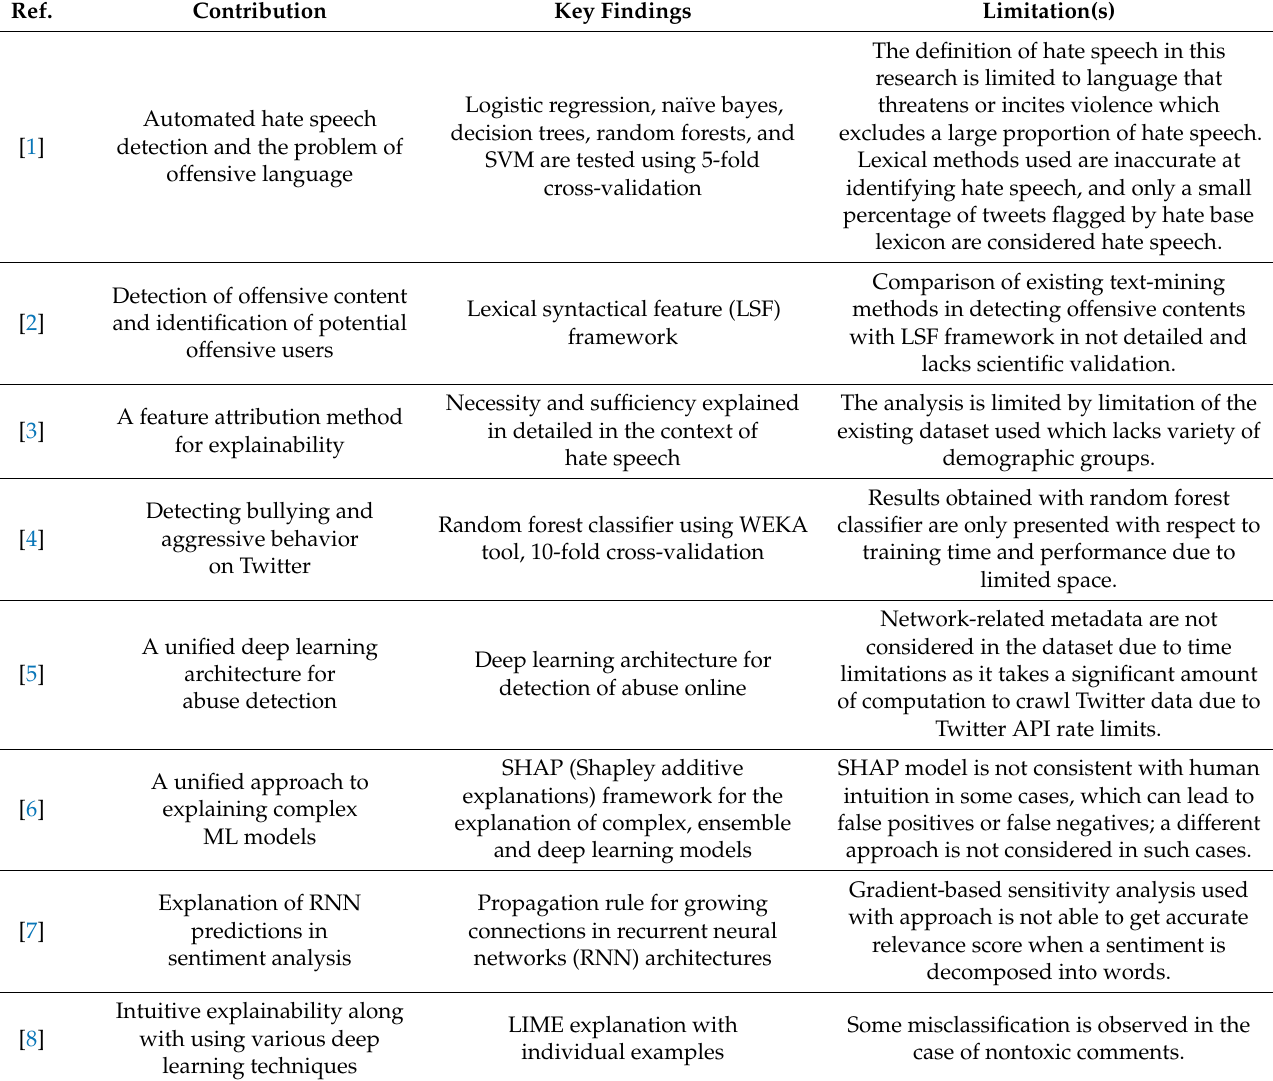
Table 1. Summary of